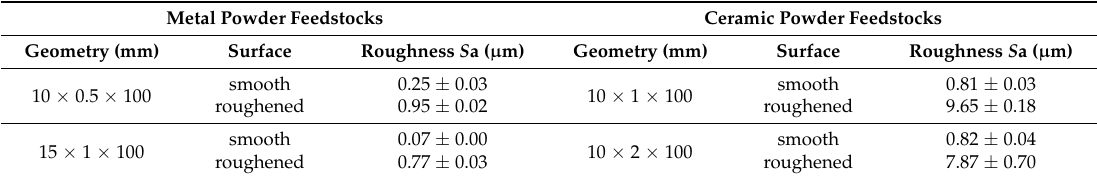
Table 2. Characteristics of slit dies used.